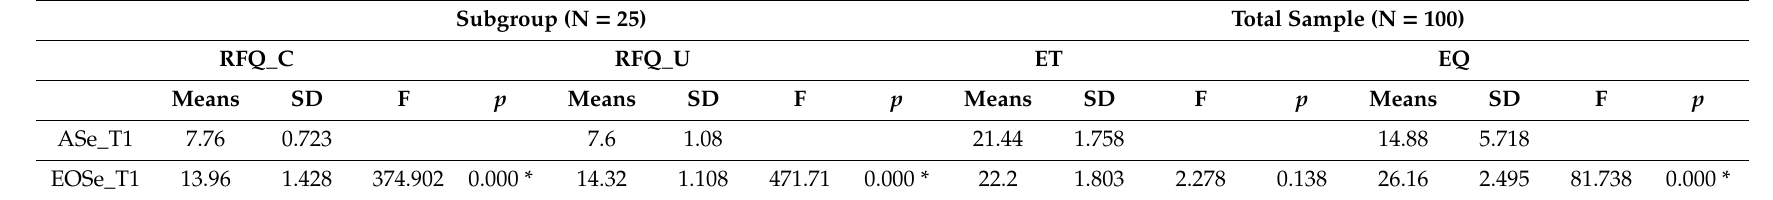
Table 5. Comparison between ASe and EOSe at